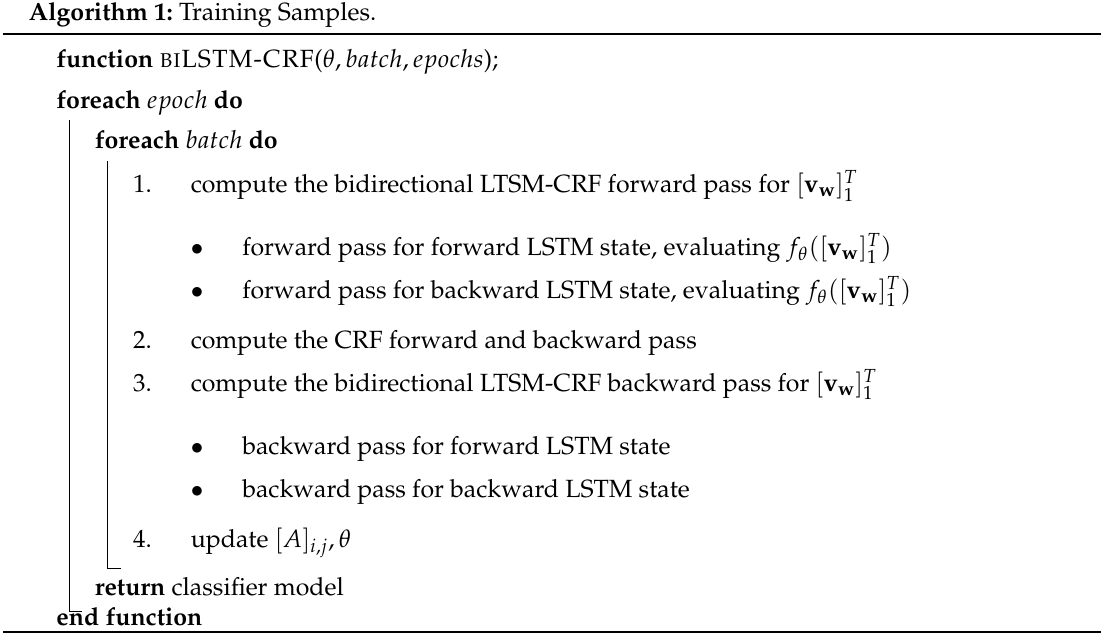
Algorithm 1: Training